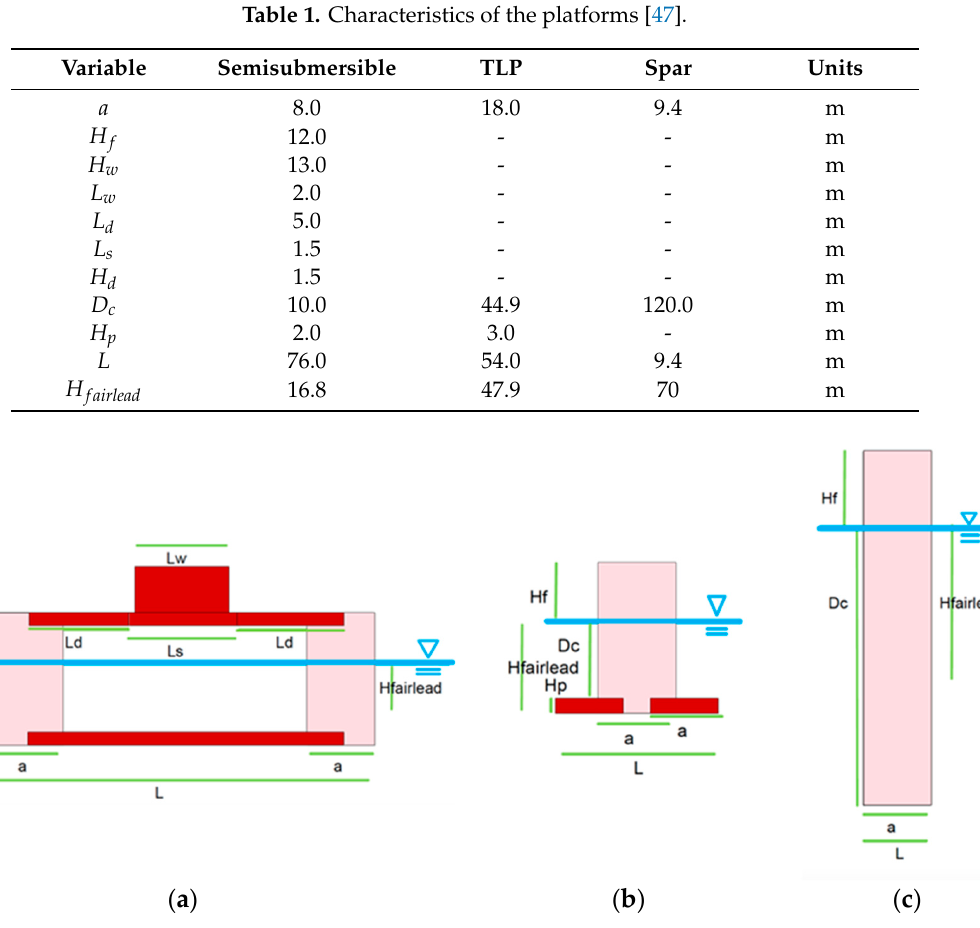
Figure 5. Bathymetry of the North of Spain.